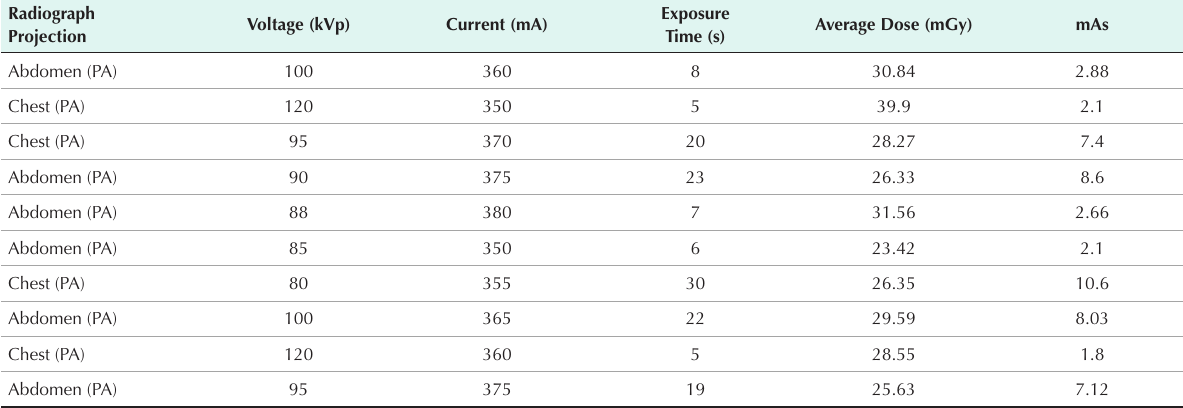
Table 3. The Technical Parameters of X-ray Tube for Age Group of 50-70 Years Radiograph